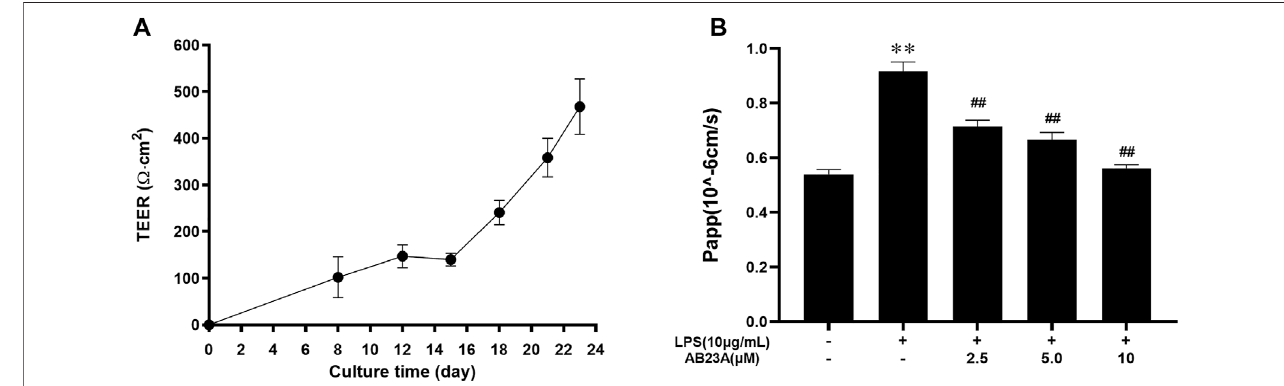
FIGURE 4 | AB23A effects on intestinal barrier permeability induced by LPS. (A) At various time points, the transepithelial electrical resistance (TEER) was assessed. (B) The apparent permeability coef fi cient (Papp) test was utilized for assessing intestinal permeability in vitro . ** p < 0.01 vs. control; ## p < 0.01 vs. LPS (10 μ g/ml).